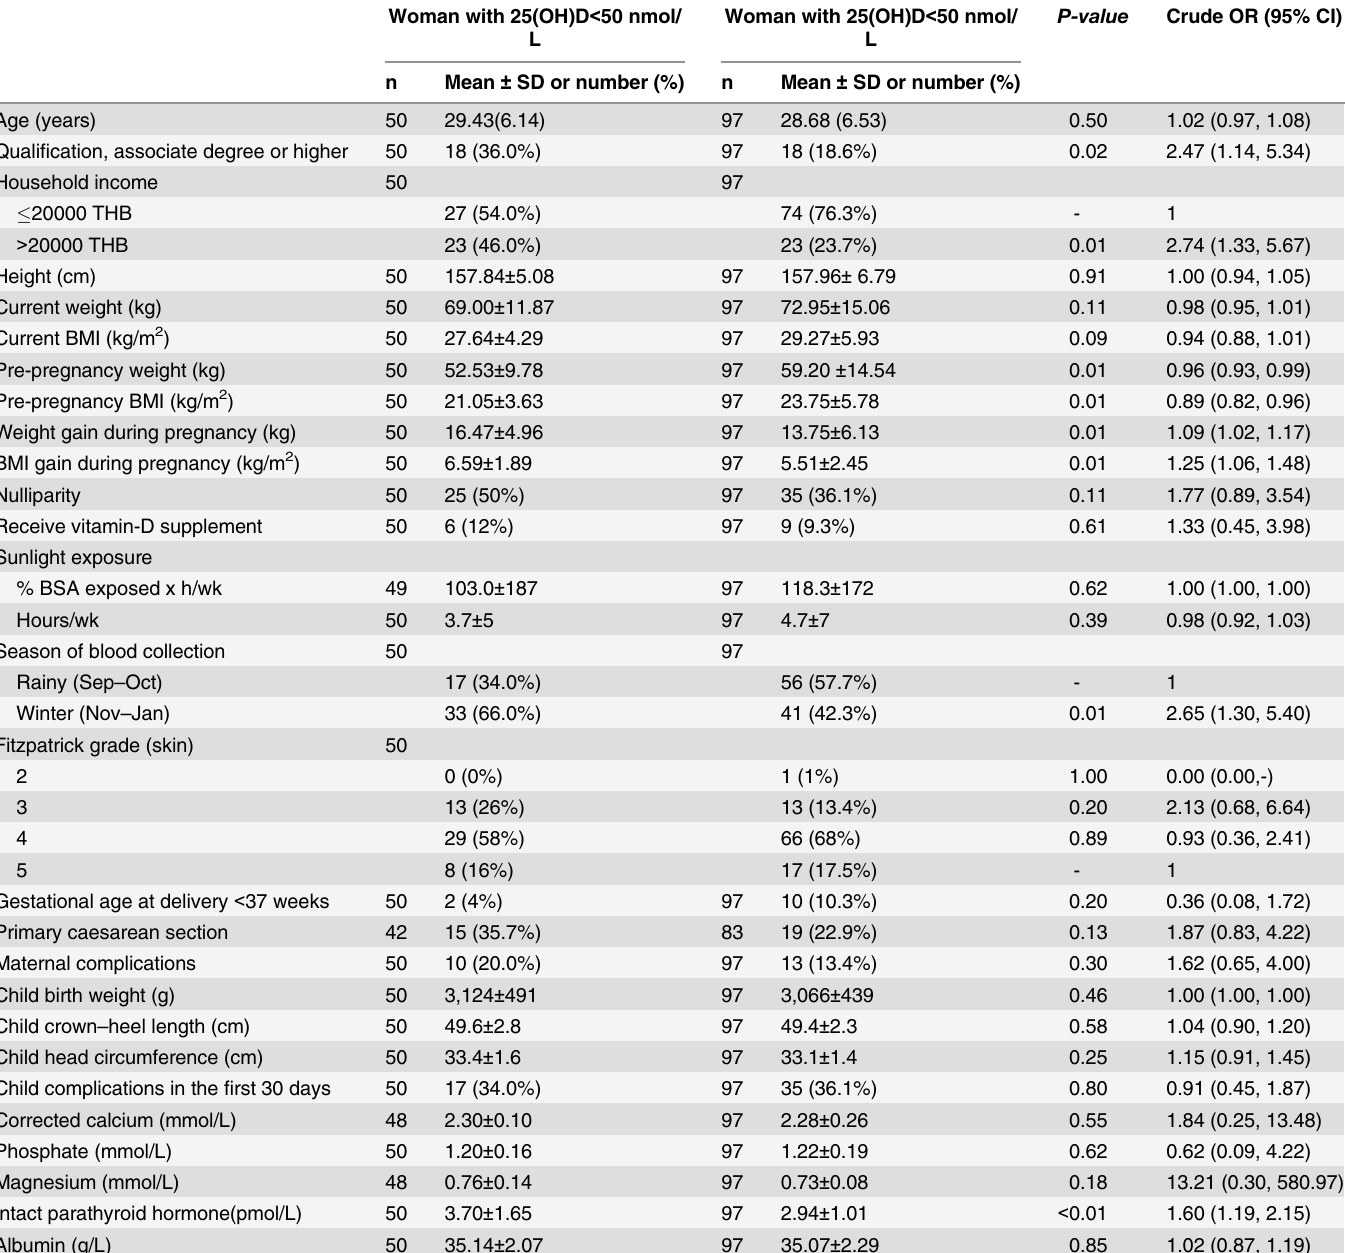
Table 2. Univariate analysis of investigated factors associated with a plasma level of 25-hydroxyvitamin D < 50 nmol/L (n = 147).